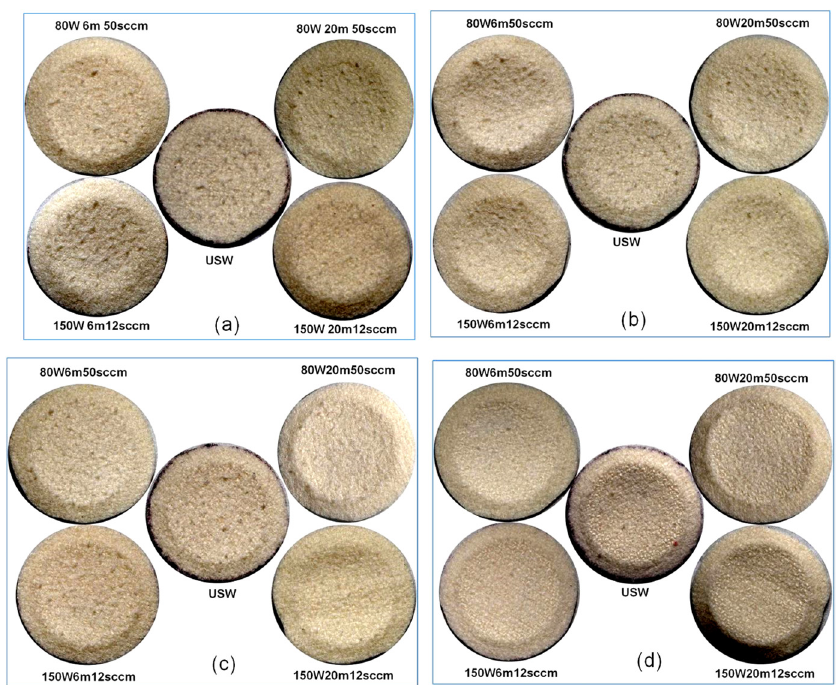
Figure 3. Effect of number of abrasion cycles on the surface damage of unscoured wool fabrics: ( a )